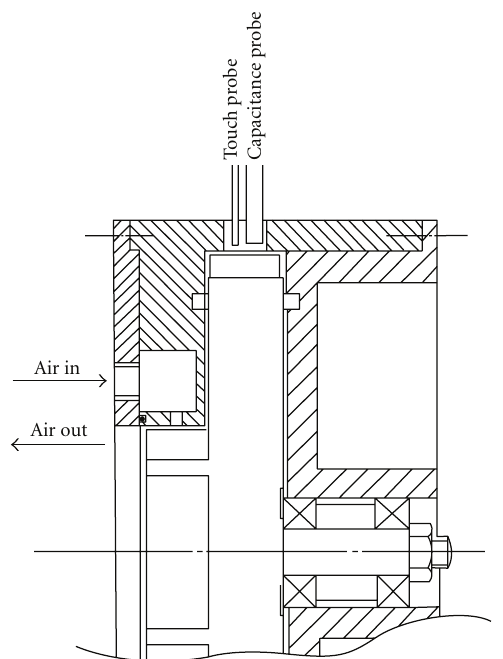
Figure 5: Spinning rig design used to evaluate the performance of the FM capacitance probe. The capacitance probe was mounted on a traverse actuator with touch probe to enable on-line calibration.